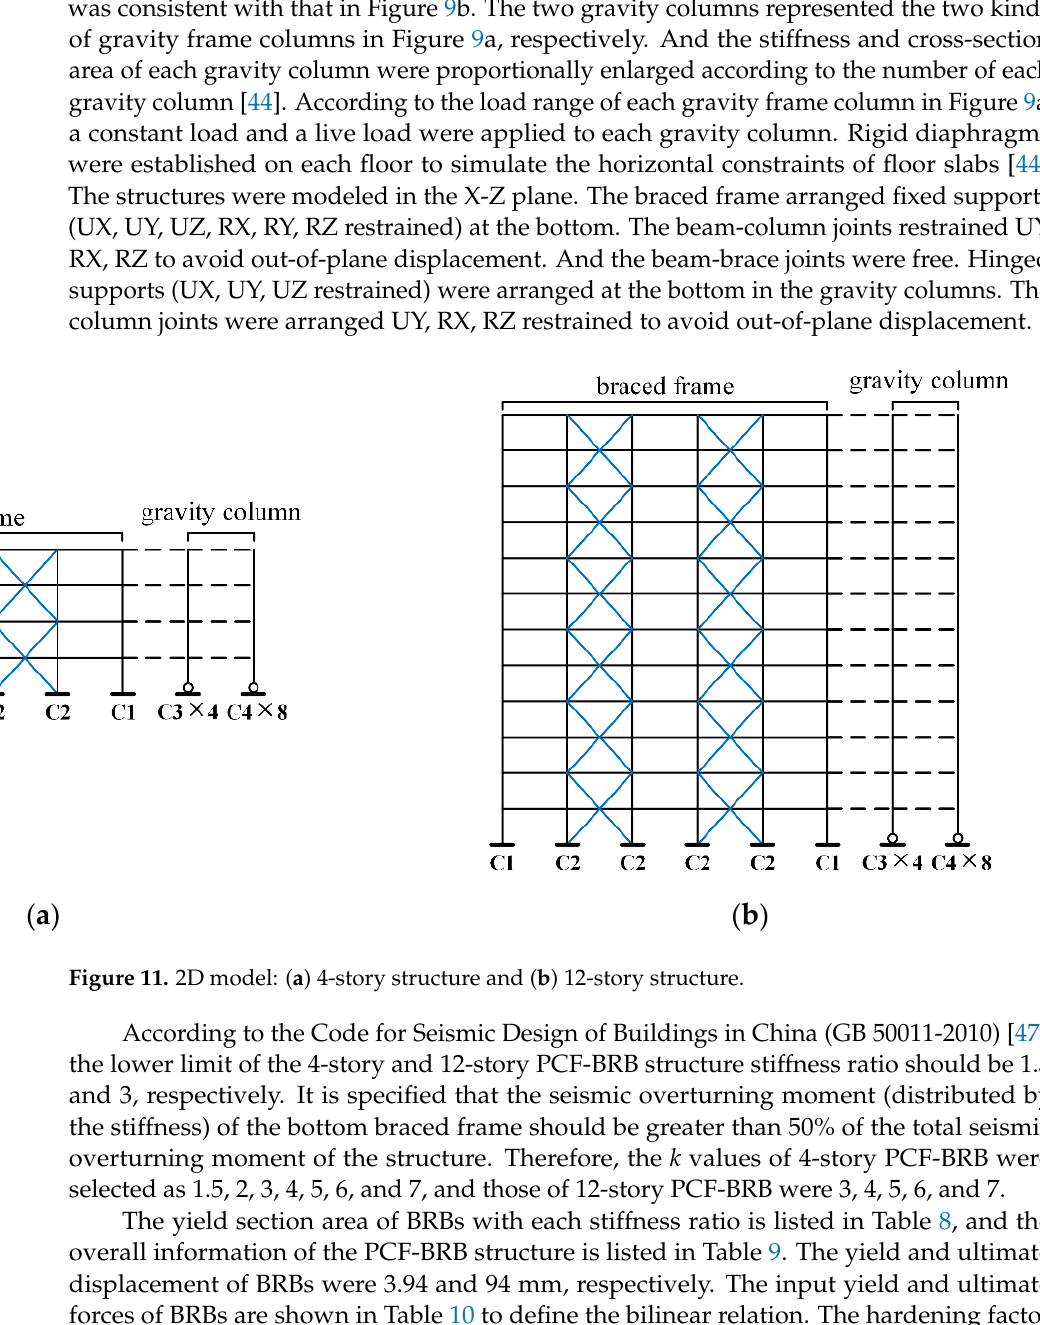
Table 7. Column and brace dimensions.